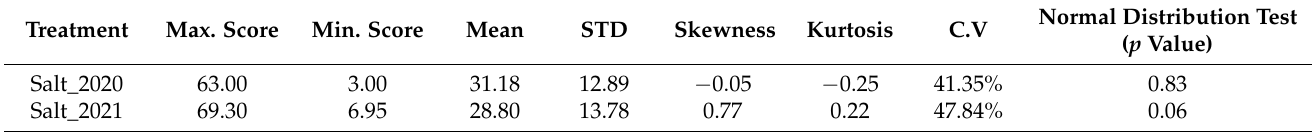
Table 1. The salt injury indexes of the germplasm in two years.